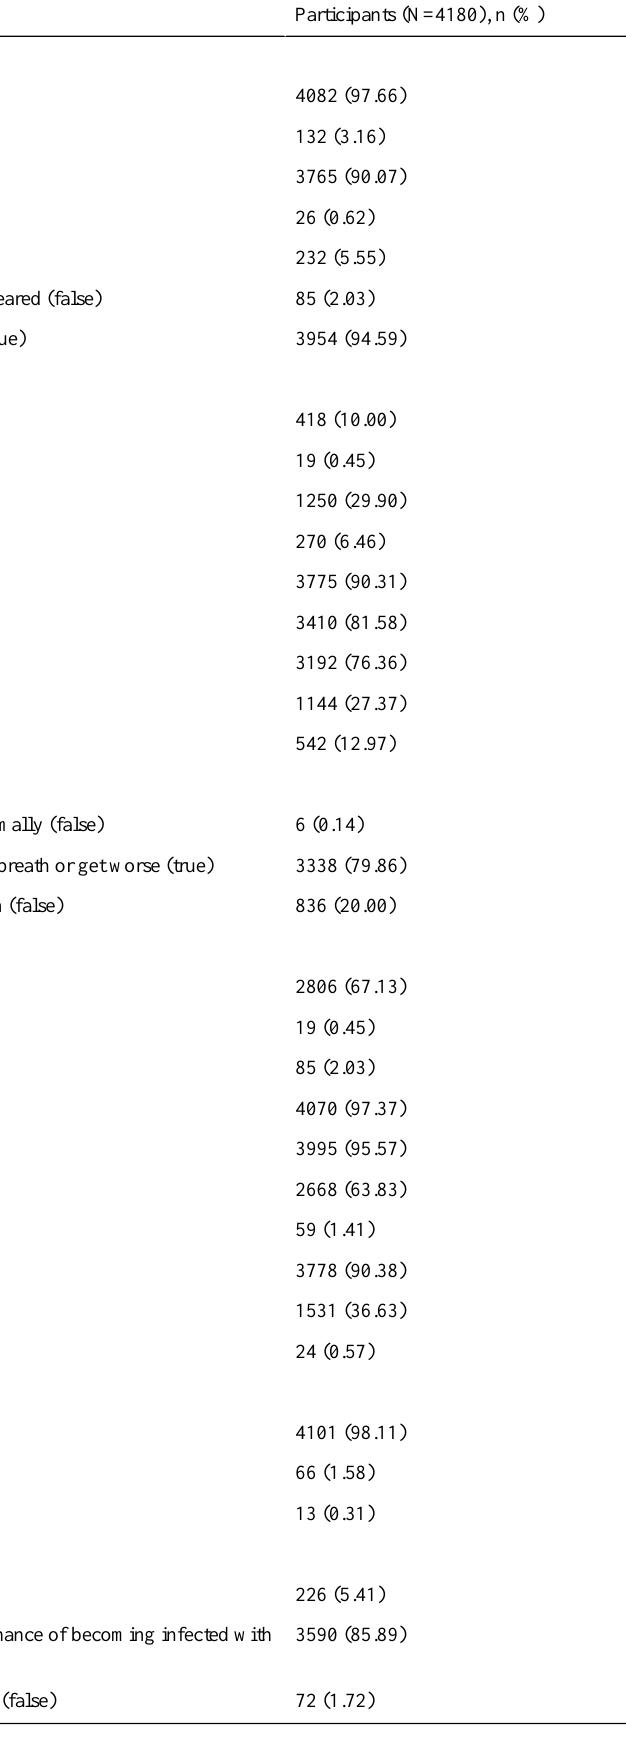
Table 2. Questionnaire of knowledge about